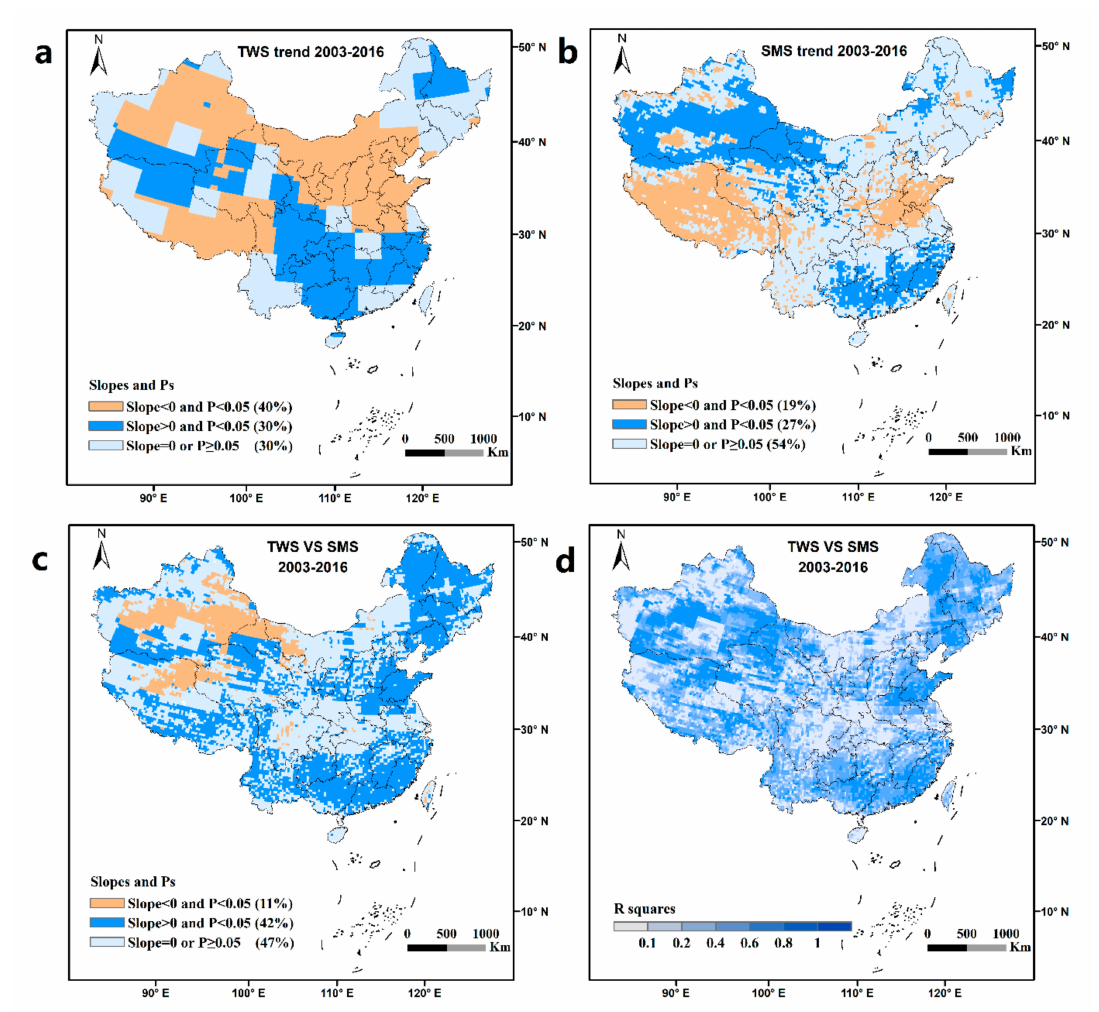
Figure 2. The slopes, p values (at the 5% significance level) of linear regression models over the period 2003–2016 per pixel. ( a ) The spatial pattern of slope in observed terrestrial water storage derived from gravity satellite dataset. ( b ) The spatial pattern of the slope in the observed soil moisture storage was simulated from the Global Land Data Assimilation System (GLDAS) Noah model. ( c ) The slope of terrestrial water storage and soil moisture storage, blue represents the same trend and red represents the opposite. ( d ) R 2